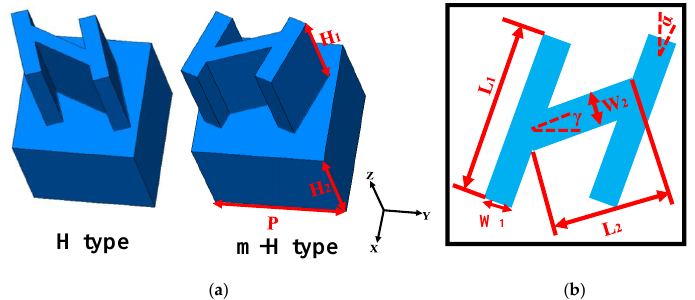
Figure 1. ( a ) The 3D structure of our proposed chiral metasurface; ( b ) the structural parameters.